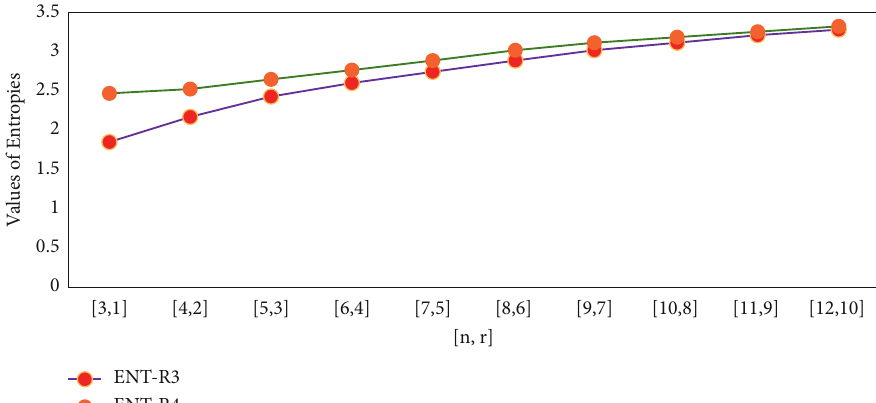
Figure 8: Comparison of Randic entropies for α � 1/2 and for α � − 1/2 for the coronoid system C